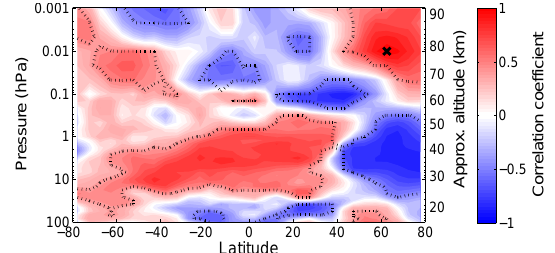
Figure 6. Correlation of middle atmosphere (cid:49)T relative to (cid:49)T at 63 ◦ N, 0.01hPa (region of maximum mesospheric cooling over Trondheim); 99% confidence level dotted, correlation baseline re- gion indicated by a black cross. Figure 7. (a–c) Latitude–height cross-section of 5-day average tem-